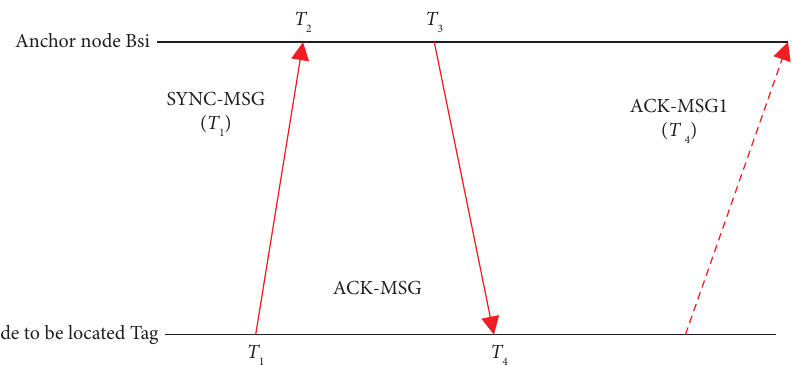
Figure 4: Software time synchronization principle.